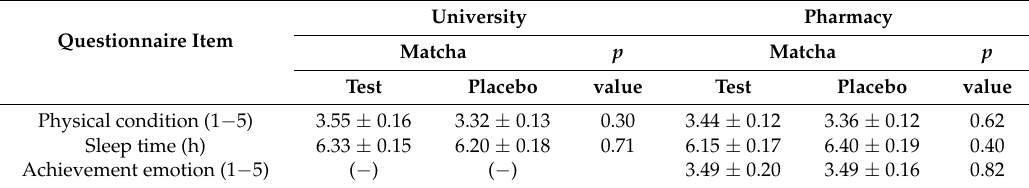
Table 5. Effect of consumption of test- and placebo-matcha by students at university and pharmacy practice on psychosocial responses, as assess from a questionnaire.